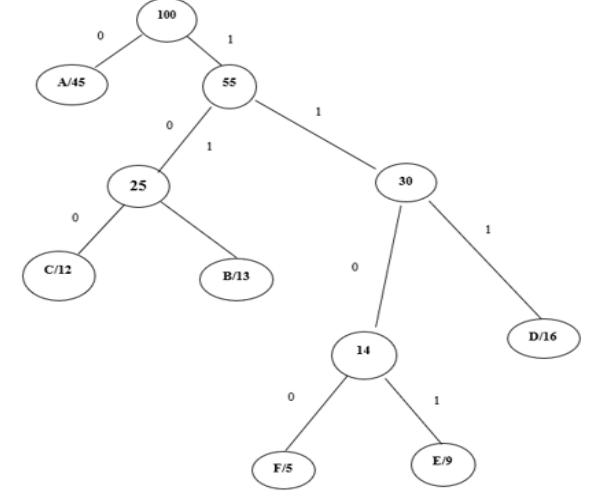
Figure 4. Dynamic Huffman - Binary tree